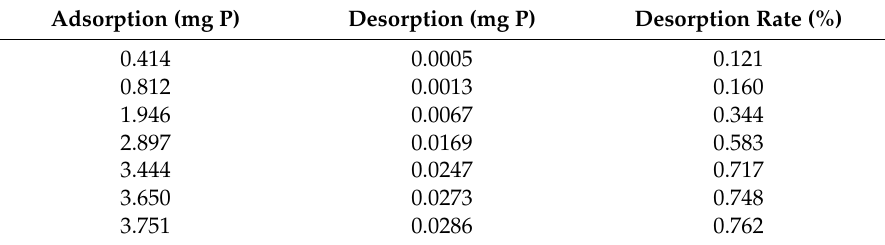
Table 6. Desorption of ZSFB composite fiber in clean